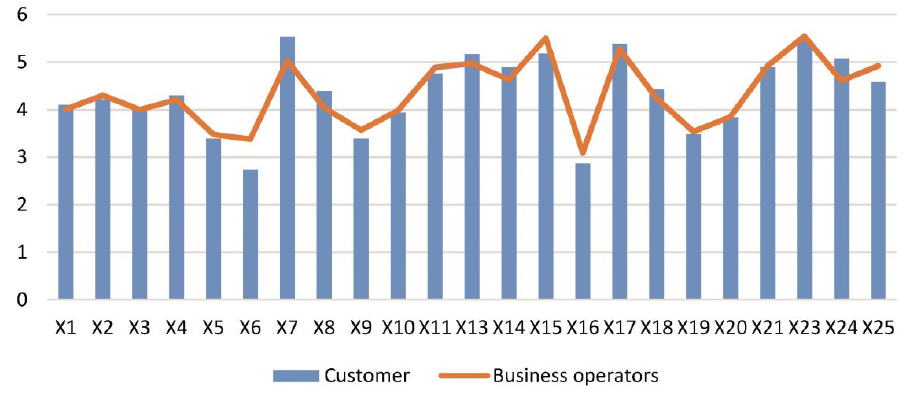
Figure 2. Customer and business operators weighting